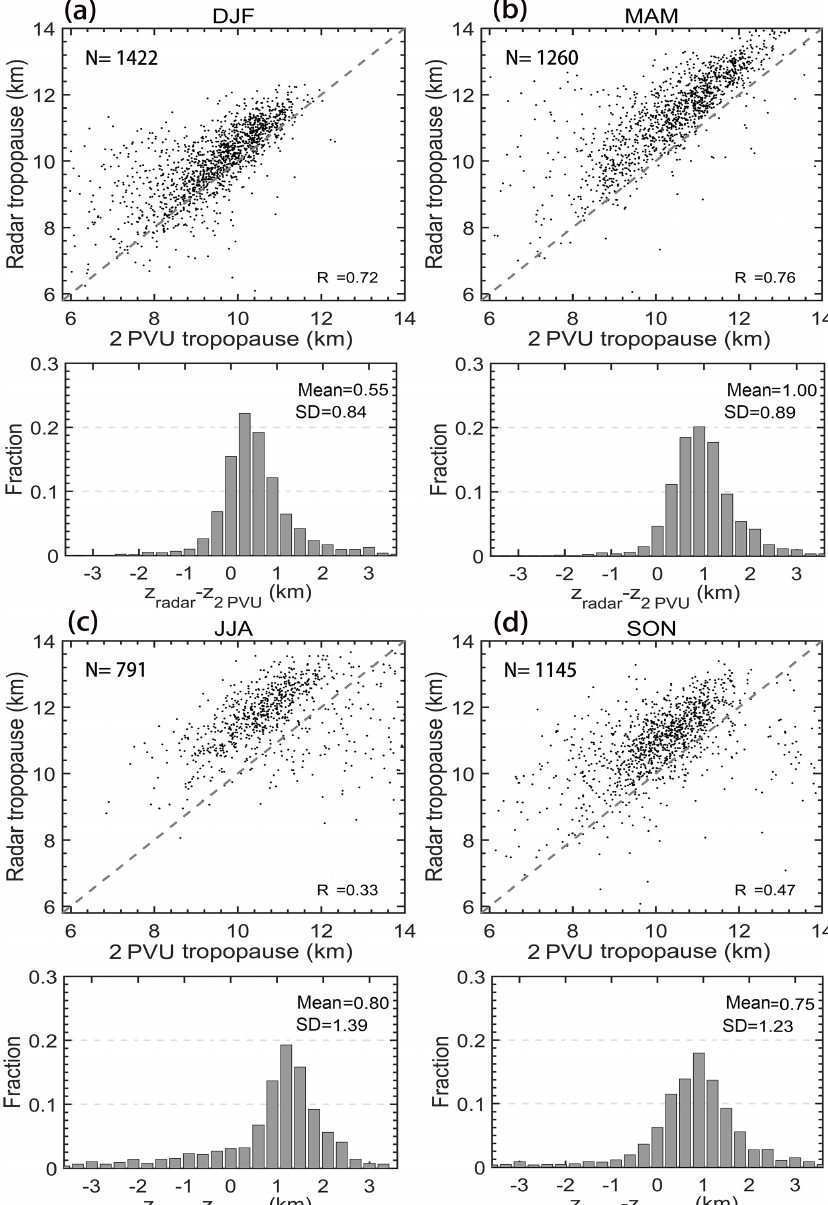
Figure 6. Same as Fig. 4, but for the comparison between the RT and the